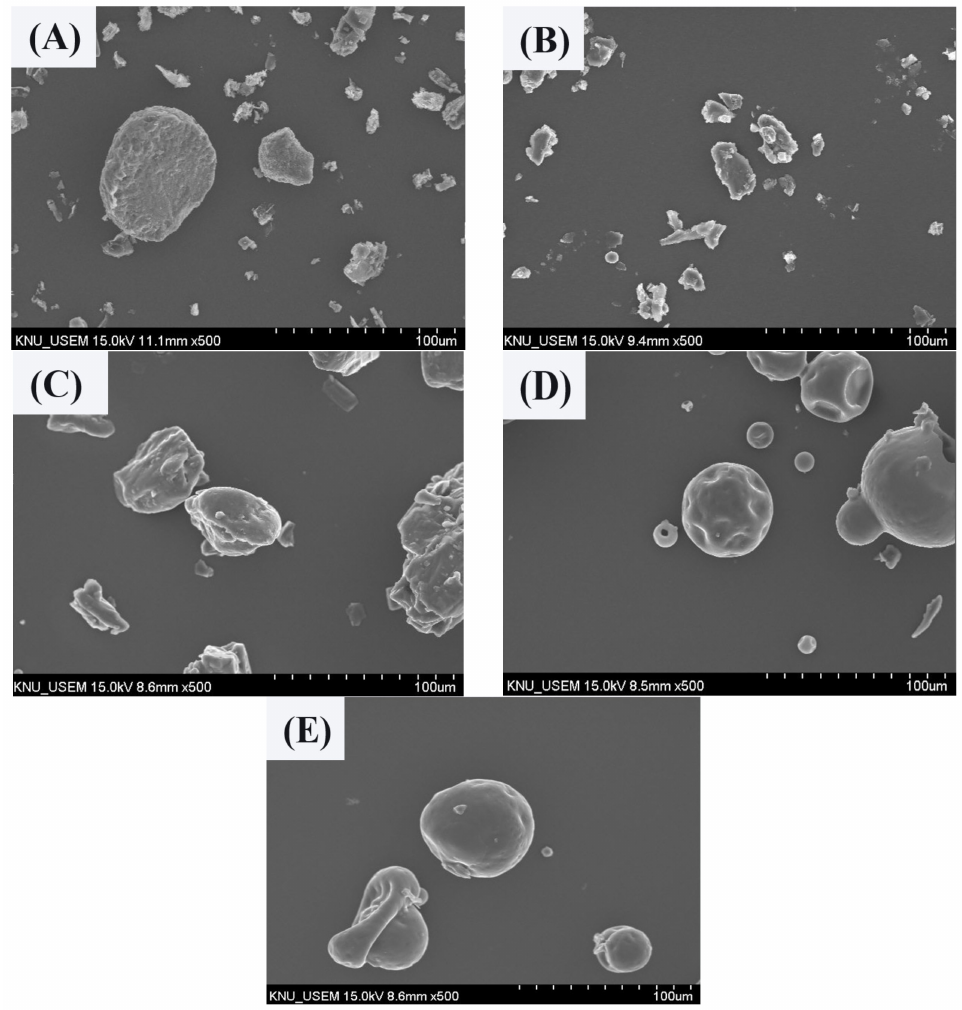
Figure 2. Scanning electron microscopy images of MUL and HME-DDS ( × 500). ( A ) MUL pow- der (MUL), ( B ) only MUL powder extrudate (MUL-HME), ( C ) MUL-HME-F1, ( D ) MUL-HME-F2, ( E ) MUL-HME-F3.